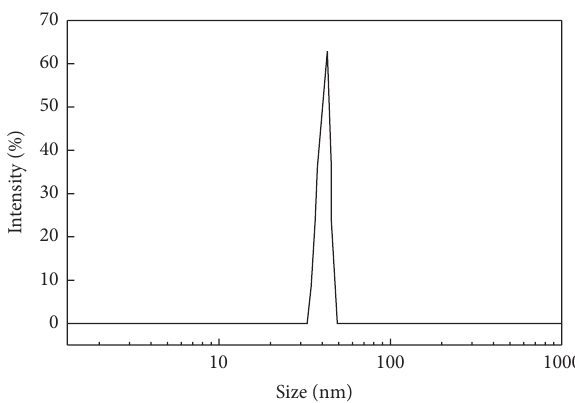
Figure 3: Diameter distribution of the synthesized nanocrystals.